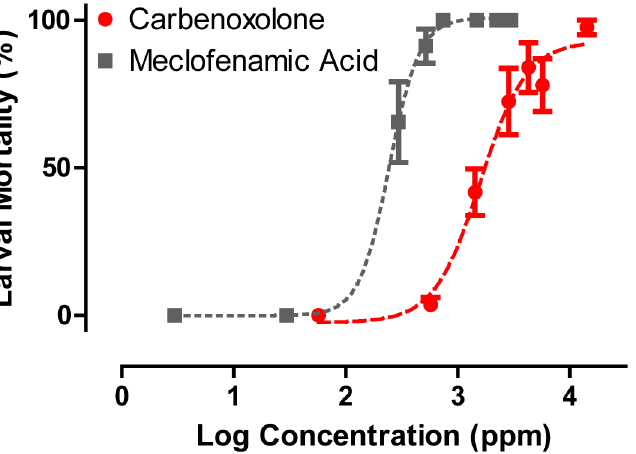
Fig 4. Dose-response curves of gap junction inhibitors added to the rearing water of 1 st instar larval A . aegypti mosquitoes (carbenoxolone R 2 = 0.873 and meclofenamic acid R 2 = 0.957). Larval mortality was assessed 24 h after adding the inhibitors. LC 50 for meclofenamic acid and carbenoxolone are 0.83 mM and 2.84 mM, respectively. Values are means ± SEM. n = 4 – 8 replicates of five larvae per concentration